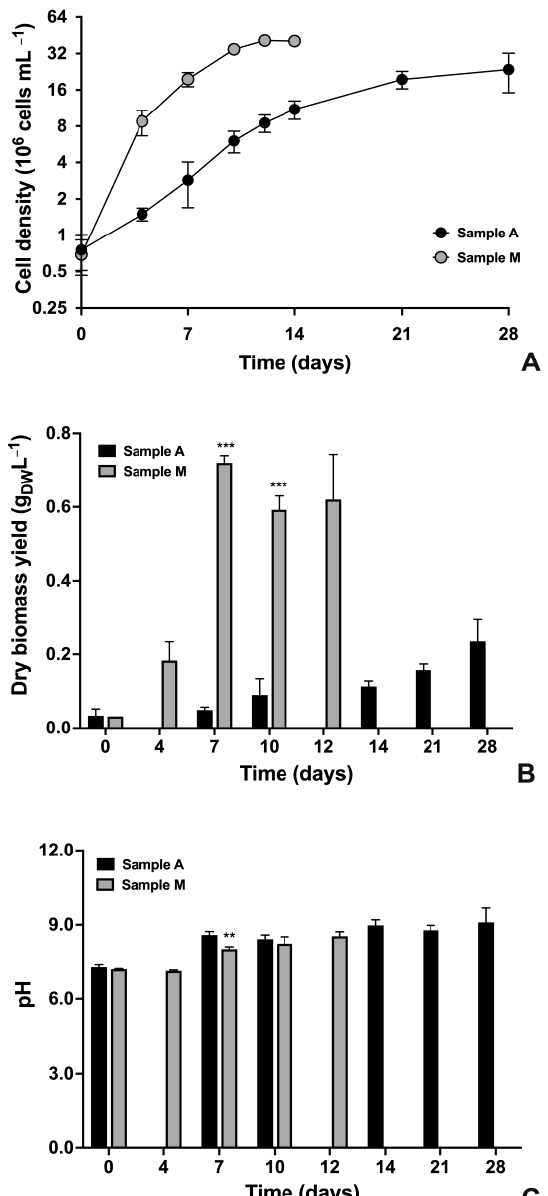
Figure 1. Growth parameters of autotrophic (A) and mixotrophic (M) cultures of N. oleoabundans during a cultivation period of 28 d for culture A and of 12 or 14 d for culture M. ( A ) Growth kinetics plotted on a base 2 logarithmic scale; cell density values of cultures were used (10 6 cells mL − 1 ). ( B ) Dry biomass yield (g DW L − 1 ). ( C ) pH trend in culture media harvested from samples A and M. In ( A ), sample A, black circles; sample M, grey circles. In ( B , C ), sample A, black histograms; sample M, grey histograms. Data refer to means ± standard deviations ( n ≥ 3). In ( A , B ), differences between samples A and M were always significant ( p < 0.001; ***), except at the inoculation time (time 0). In ( C ), differences between samples A and M were significant ( p < 0.01; **) only at day seven.